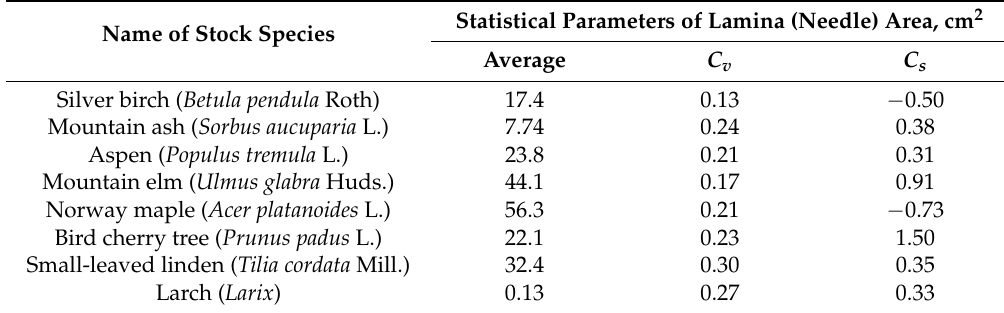
Table 1. Statistical parameters of dimensions of laminae for the analyzed deciduous species and larch. Statistical Parameters of Lamina (Needle) Area, cm 2 Name of Stock Species Average C v C s Silver birch ( Betula pendula Roth) 17.4 0.13 − 0.50 Mountain ash ( Sorbus aucuparia L.) 7.74 0.24 0.38 Aspen ( Populus tremula L.) 23.8 0.21 0.31 Mountain elm ( Ulmus glabra Huds.) 44.1 0.17 0.91 Norway maple ( Acer platanoides L.) 56.3 0.21 − 0.73 Bird cherry tree ( Prunus padus L.) 22.1 0.23 1.50 Small-leaved linden ( Tilia cordata Mill.) 32.4 0.30 0.35 Larch ( Larix ) 0.13 0.27 0.33